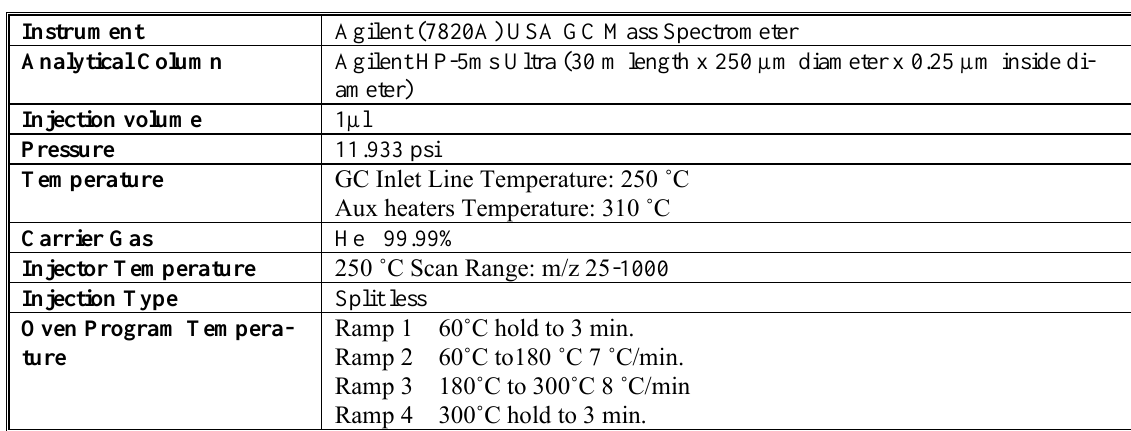
Table 1. GC/MS conditions. (4)